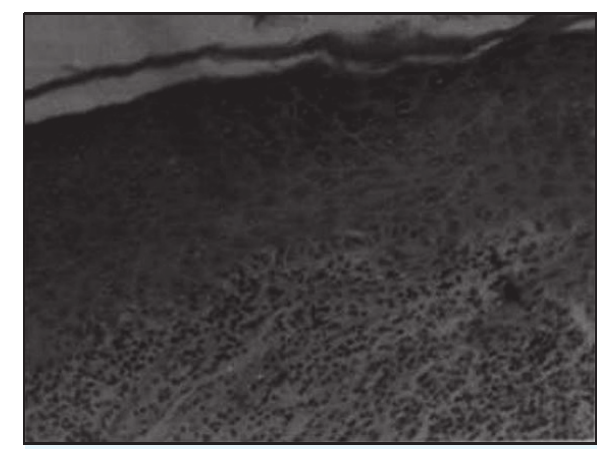
Figure 1b. After six weeks of topical corticosteroid treatment, and after scaling and polishing